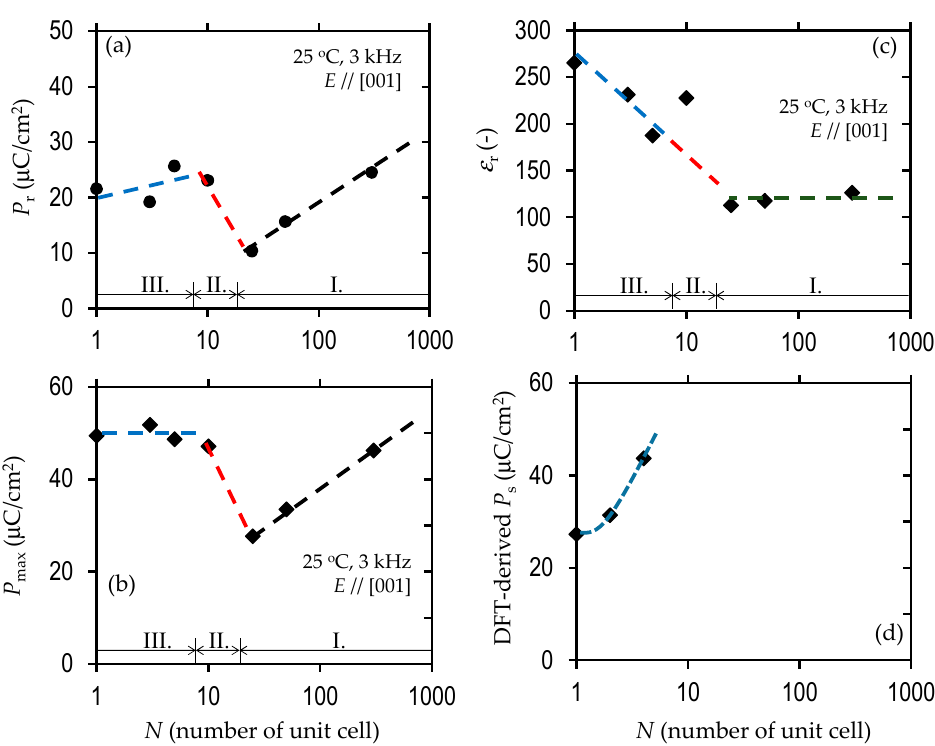
Figure 6. ( a ) Remanent polarization ( P r ), ( b ) relative dielectric permittivity ( ε r ), ( c ) polarization maximum at the maximum E ( P max ), and ( d ) spontaneous polarization ( P s ) from DFT calculations of the unified unit cells in Figure 2.